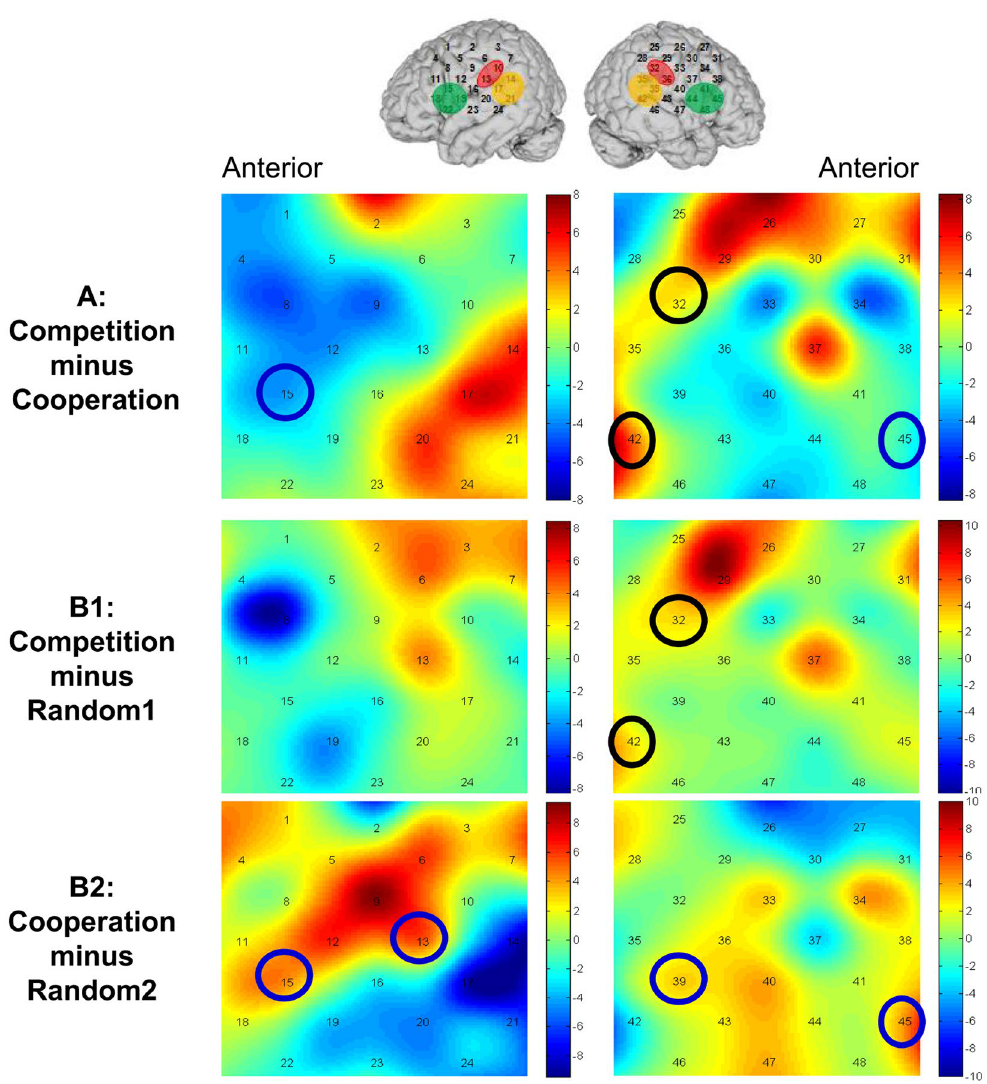
Figure 5. The t-test heat maps of inter-brain neural synchronization (INS) values. ( A ) Contrast result of competition condition minus cooperation condition. ( B1 ) Contrast result of competition condition minus scrambled competitive baseline; and ( B2 ) contrast result of cooperation condition minus scrambled cooperative baseline. The color bars show the t values. The black (blue) solid circles represent the ROI channels that showed significantly higher ( p < 0.05) INS in the competition (cooperation) conditions,